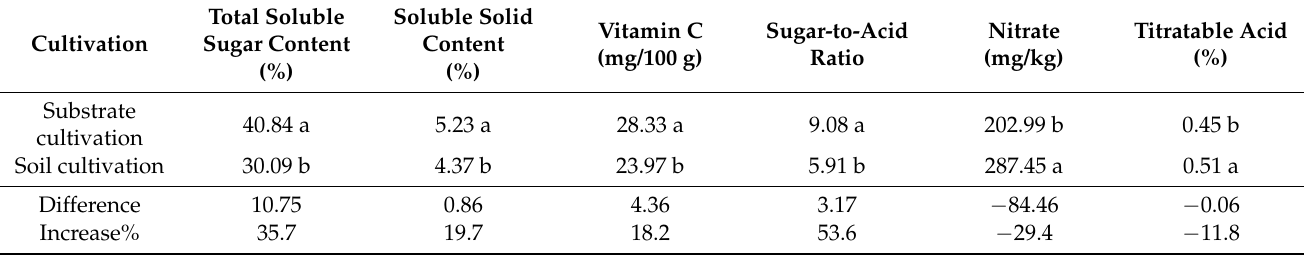
Table 6. Tomato quality under substrate-based and soil